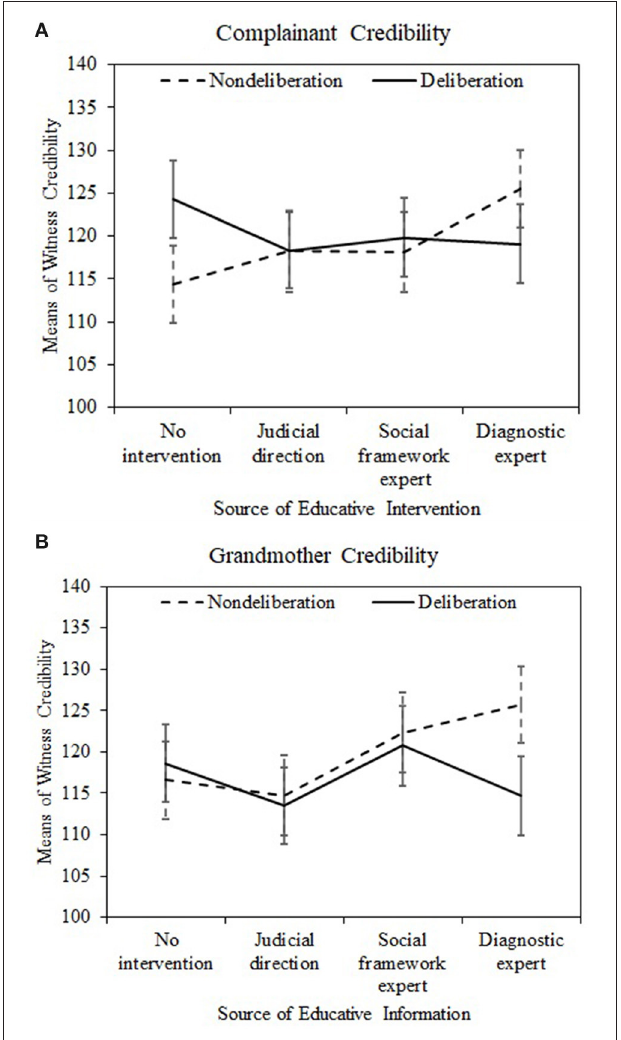
FIGURE 1 | Perceived credibility of the complainant (A) and the grandmother (B) by decision type and source of educative intervention. Error bars are 95% confidence intervals.